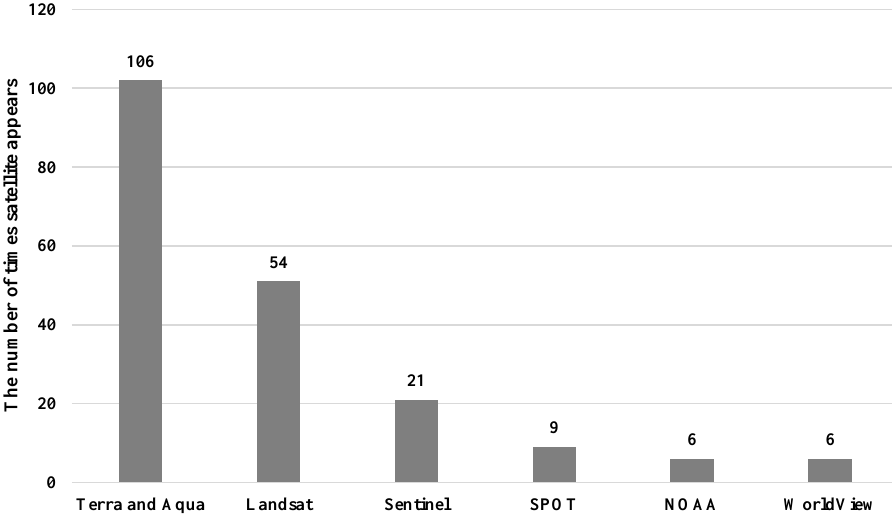
Figure 1. The number of times the top six frequently occurring satellites in 196